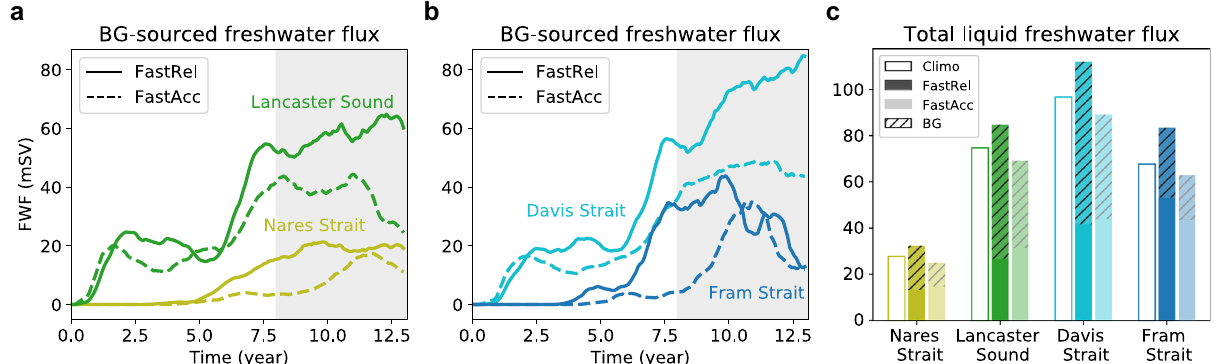
Fig. 3 Beaufort Gyre-sourced freshwater fl ux at major Arctic – Atlantic ocean gateways. Time series of the Beaufort Gyre-sourced freshwater fl ux during FastRel (solid) and FastAcc (dashed) periods at two Canadian Arctic Archipelago pathways, Lancaster Sound and Nares Strait ( a ), as well as Davis and Fram Straits ( b ). Locations of these gateways are shown in Fig. 1a. Lines are 12-point unweighted running averages based on monthly output. c Total liquid freshwater fl ux averaged over the last 5 years (gray patches in a and b ) of the FastRel (dark) and FastAcc (light) periods, compared with the long-term climatologies (un fi lled boxes). Hatched areas of the bars indicate the Beaufort Gyre-sourced